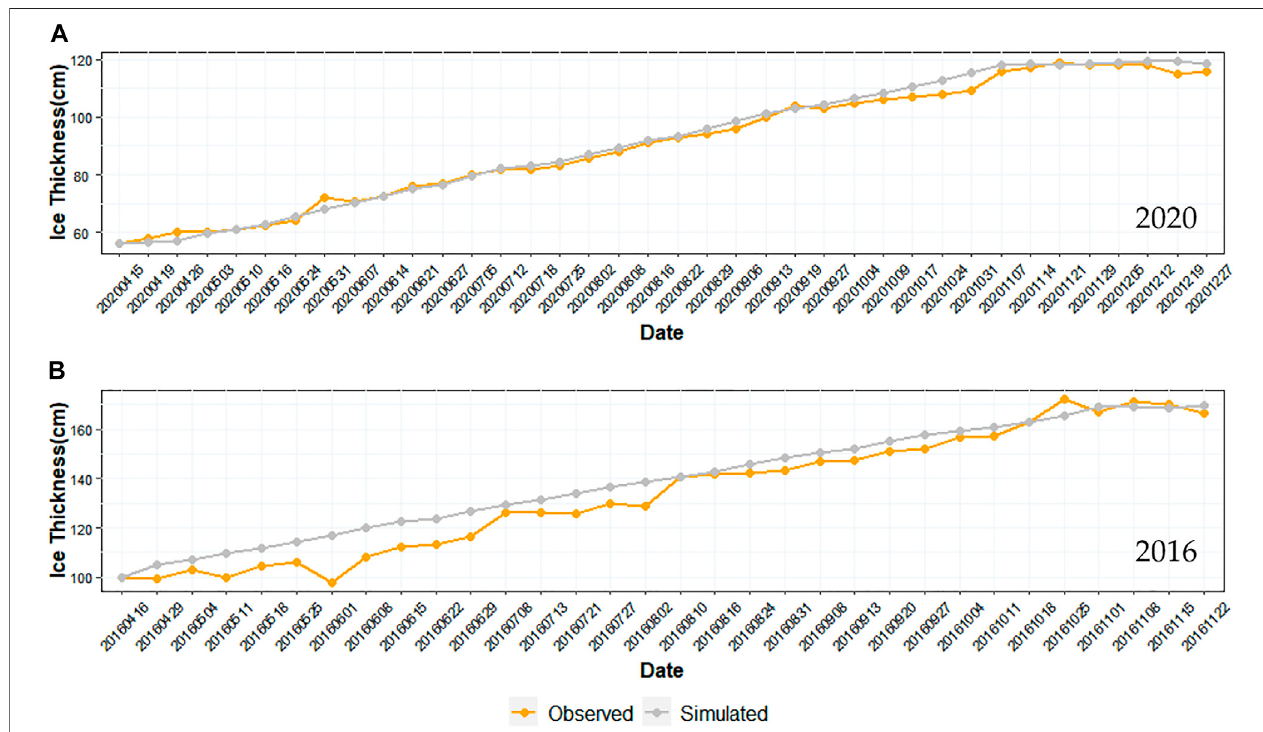
FIGURE7| Comparisonoficethicknessby fi eldobservationandmodelsimulation.[ (A) :Field-observedseaicethicknessandmodel-simulatedseaicethicknessin 2020; (B) : Field-observed sea ice thickness and model-simulated sea ice thickness in